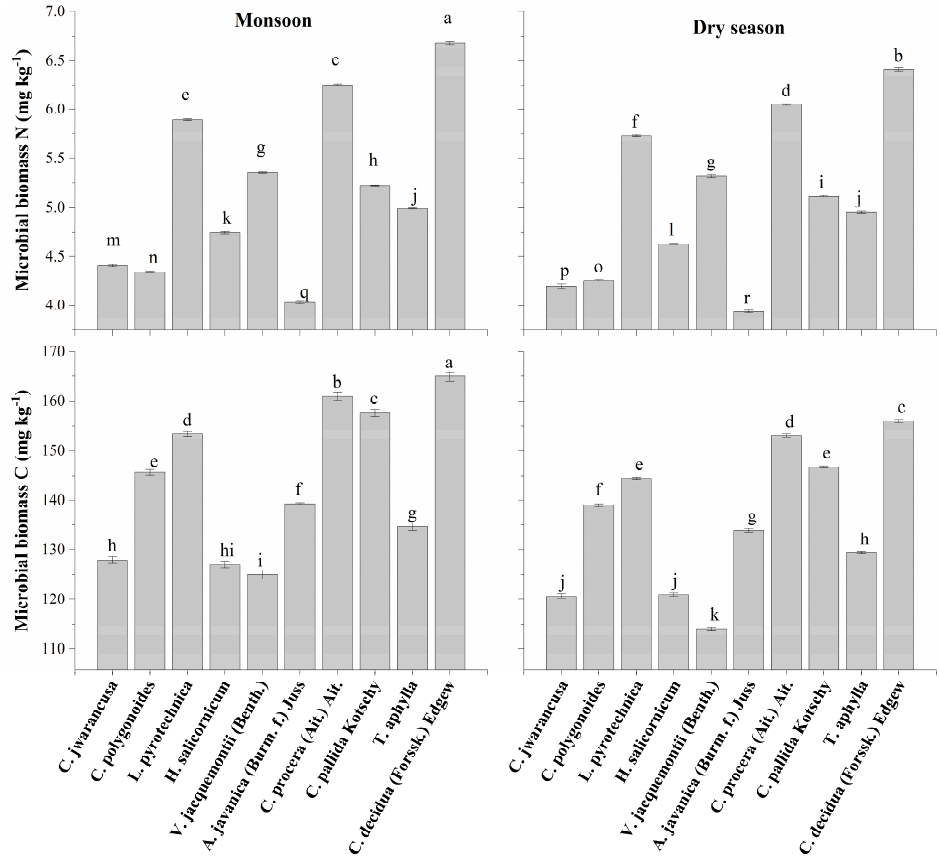
Figure 8. Microbial biomass carbon and nitrogen in the rhizosphere of different desert plants collected in monsoon and dry seasons. Different lowercase letter(s) indicate significant differences in the studied plant species according to the LSD test at p ≤ 0.05.